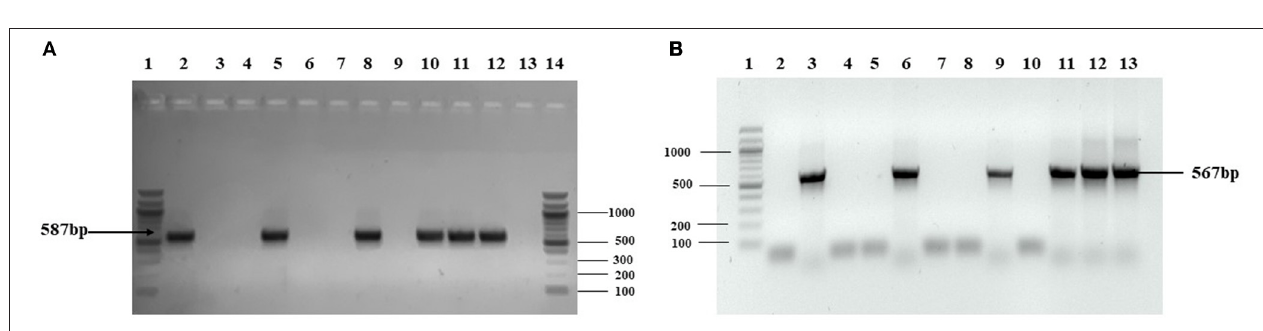
FIGURE 3 | Western blot analysis demonstrating the expression of F and HN protein E. coli . (A) purified protein through ion exchange chromatography extracted from transformed Rosetta cells. A 67 kDa protein band obtained through western blot analysis confirm the expression of F protein. Lane 1, Negative control (Untransformed Rosetta cells); Lanes 2–5, F-transformed in Rosetta cells; Lane 6, showing Pre-stained protein marker (Fermentas) (B) purified protein through ion exchange chromatography extracted from transformed Rosetta cells. A 69 kDa protein band obtained through western blot analysis confirm the expression of HN protein. Lane 1, Negative control (Untransformed Rosetta cells); Lanes 2 and 3, HN-Transformed in Rosetta cells; lane 5, Pre-stained Protein marker (Fermentas).